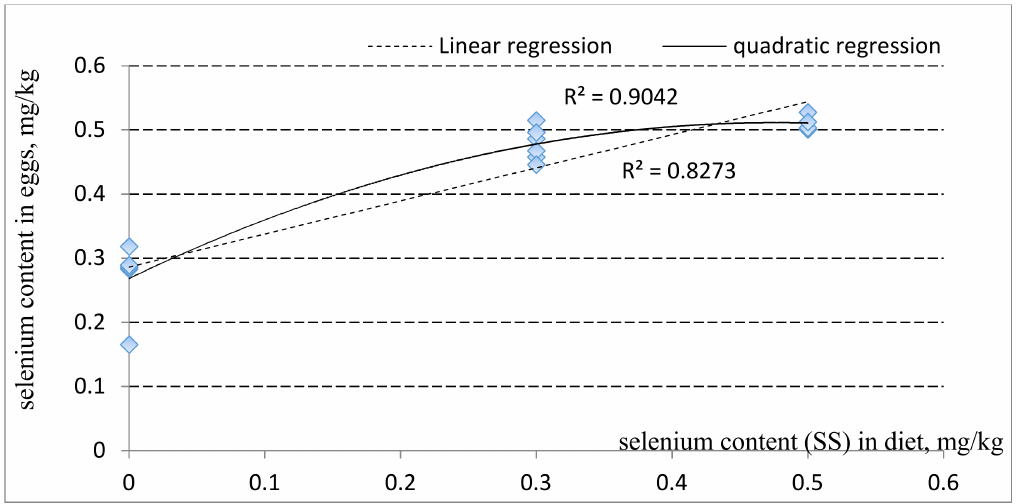
Figure 2. Linear and quadratic regression of egg selenium content (mg / kg) of laying hens on supplemental di ff erent levels of sodium selenite (mg /